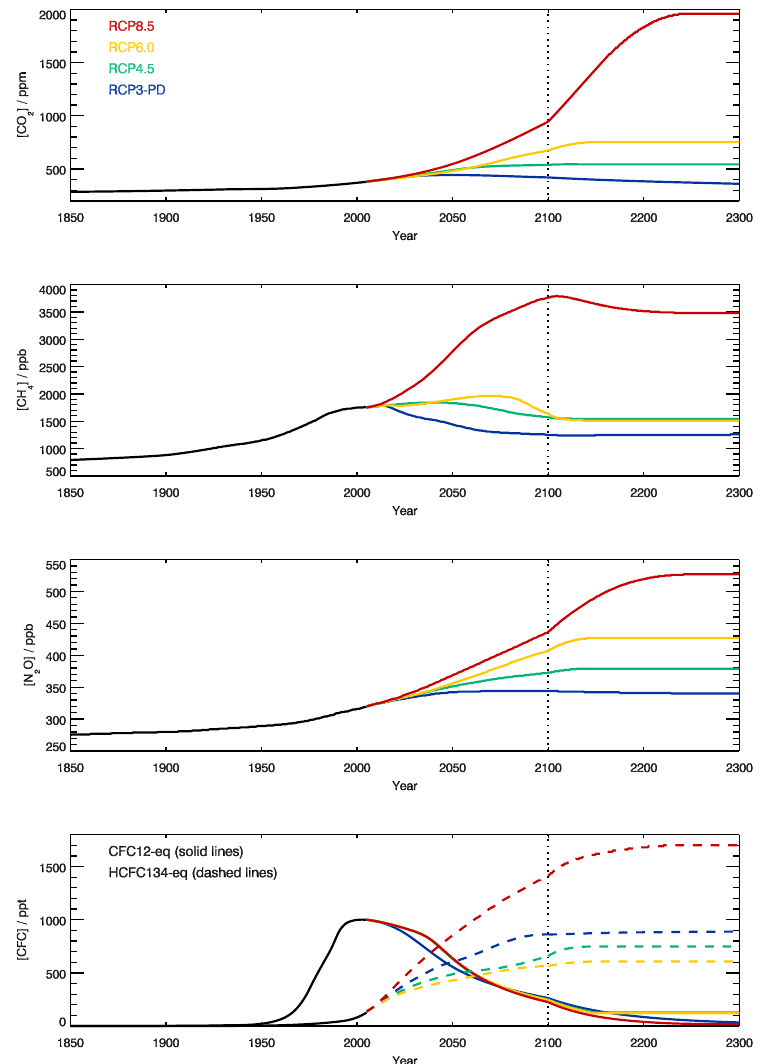
Fig. 2. Well mixed GHG concentrations used for concentration driven simulations: (a) CO 2 , (b) CH 4 , (c) N 2 O, (d) halocarbons. Plotted are historical observed concentrations (black lines), and the four RCPs as well as their extensions beyond 2100 (RCP8.5: red; RCP6: yellow; RCP4.5: green; RCP3-PD: blue). See Meinshausen et al. (2011) for further details. Note that the x-axis beyond 2100 is